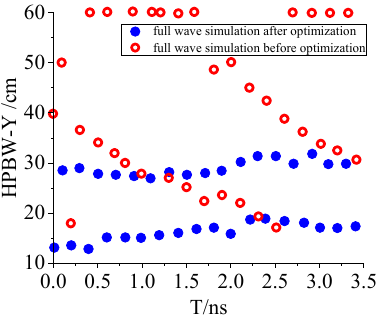
Figure 11. Comparison of the rectangular array’s half-power beam-width before and after optimization.